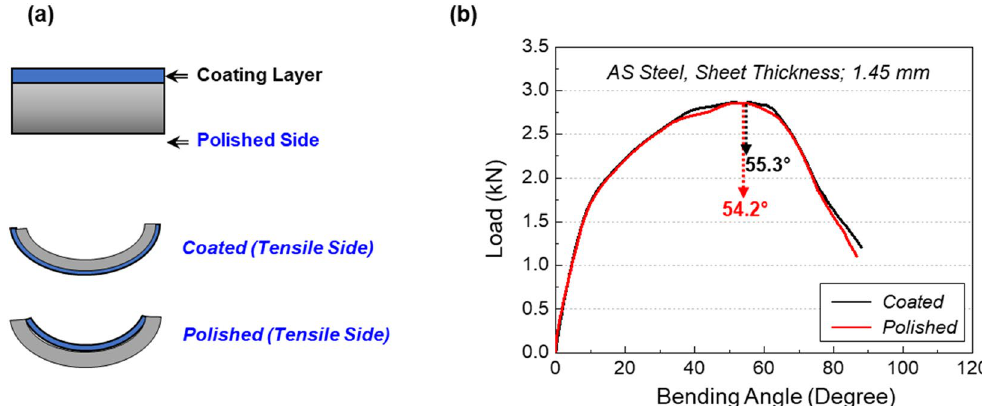
Figure 6. ( a ) Schematic diagrams of shapes of the bending specimen where the coating or polished-substrate surface is tensile-strained during the bending test, which is referred to as ‘Coated’ or ‘Polished’, respectively. ( b ) Load-bending-angle curves of the Coated and Polished bending specimens for the AS steel.